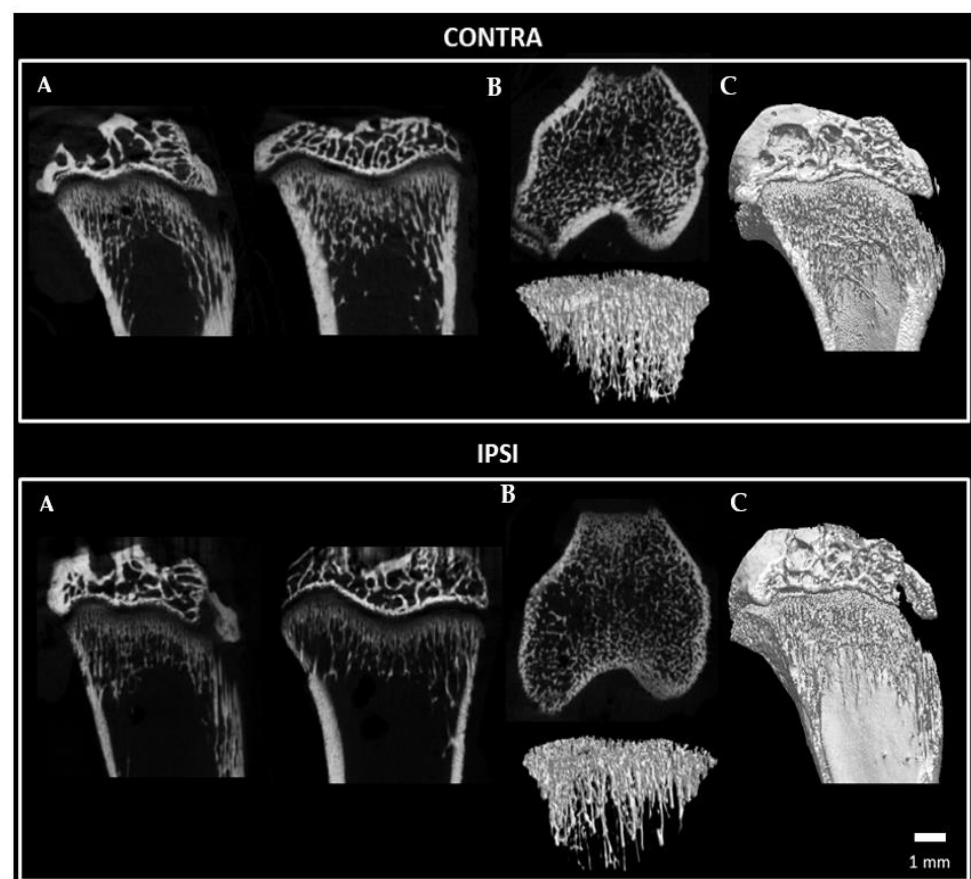
Figure 12. Representative micro-CT images showing the modified trabecular architecture of the tibia bone in a CCI rat. ( A ) Coronal, sagittal and trans-axial sections; ( B ) Three-dimensional trabecular architecture; ( C ) Three-dimensional architecture of the tibia bone in coronal view. Contralateral (Top), Ipsilateral (Bottom). Scale bar: 1 mm.